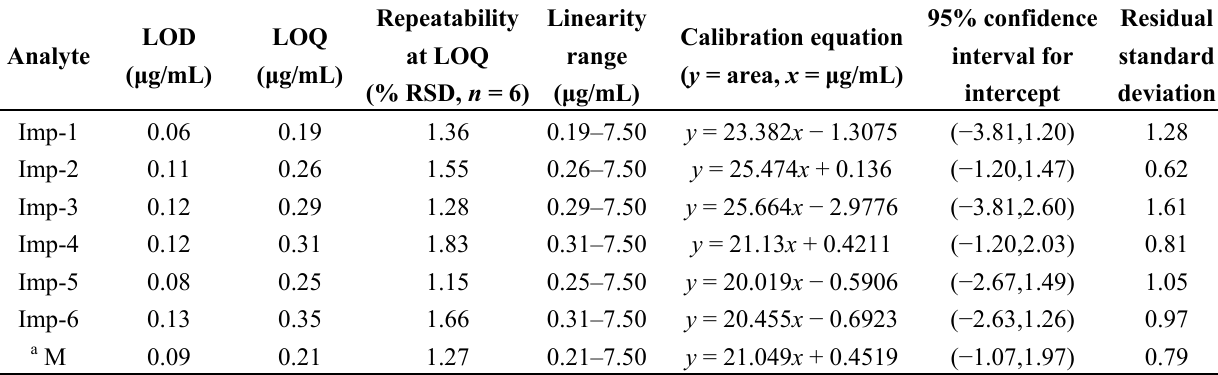
Table 3. Limit of detection (LOD), limit of quantification (LOQ) and